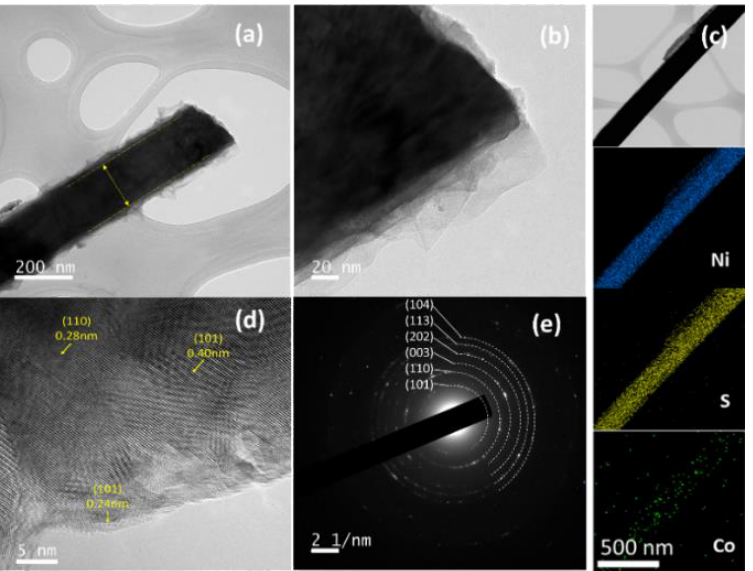
Figure 4. ( a ) Low and ( b ) high-magnification TEM images of the Co 0.5 –Ni 3 S 2 nanowire, ( c ) EDS mapping images, ( d ) lattice-resolved HRTEM image of the Co 0.5 –Ni 3 S 2 nanowire, and ( e ) SAED pattern of the Co 0.5 –Ni 3 S 2 nanowire.